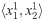
Orientation computation.(a) The geometric interpretation of the orientation computation. Here I
1 and I
2 denotes the image plane of Camera 1(red) and Camera 2(blue) respectively. The line-segment ⟨x11,x21⟩(red) denotes the ellipse’s major axis in I
1. And the line-segment ⟨x12,x22⟩(blue) denotes the ellipse’s major axis in I
2. The projection rays of those end-points define two plane Φ1 and Φ2 respectively, e.g. two red rays define Φ1. The orientation Otn can be computed from the direction of the cross line (the longer green line-segment) between two planes Φ1 and Φ2. All definitions are defined in the world coordinate system. (b) The problematic orientation computation. The measurement is drawn in red, and red dashed lines are the major-axis and minor-axis of its ellipse. A generative shape according to the particle state (Xtn,Otn,l˜) is re-projected into Camera 2 (see S2 Fig, the generative shape model). The green pixels are re-projected pixels and the yellow pixels are identical pixels. (c) The error ϵ as a function of the ratio γ. Here γ defines the length ration between the major-axis and the minor-axis of an ellipse.